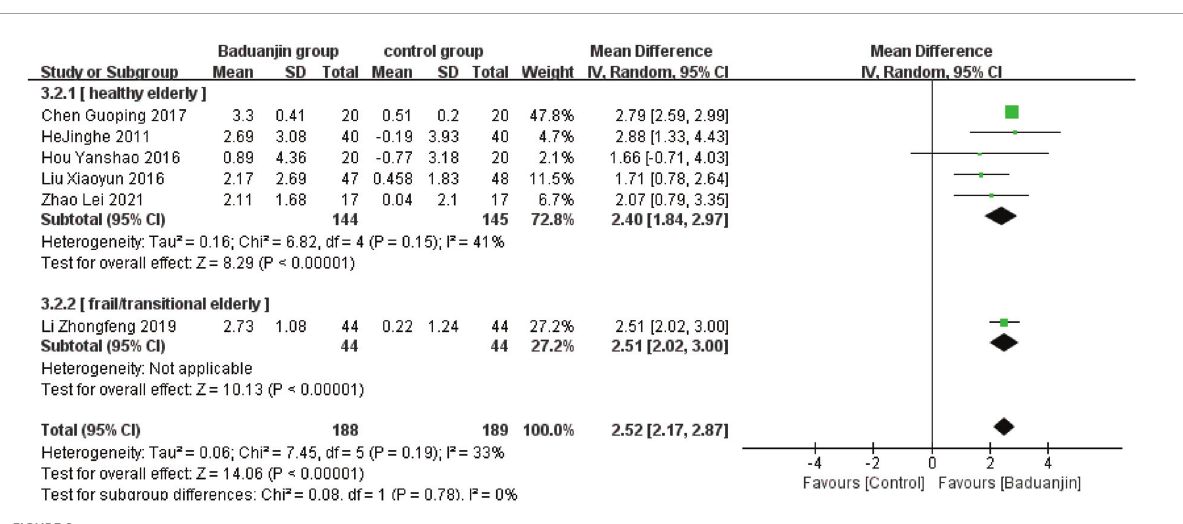
FIGURE8 Forest plot of the subgroup analysis of ECLSB for the different health status. CI, confidence interval; SD, standard